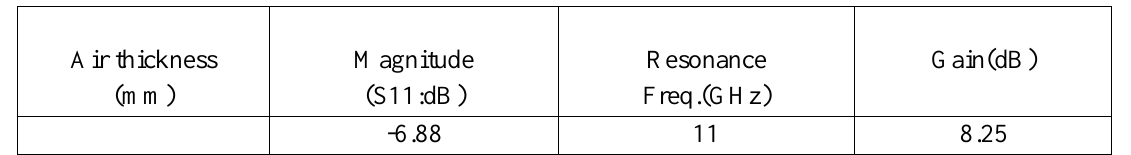
Table 1. Optimization of the air layer